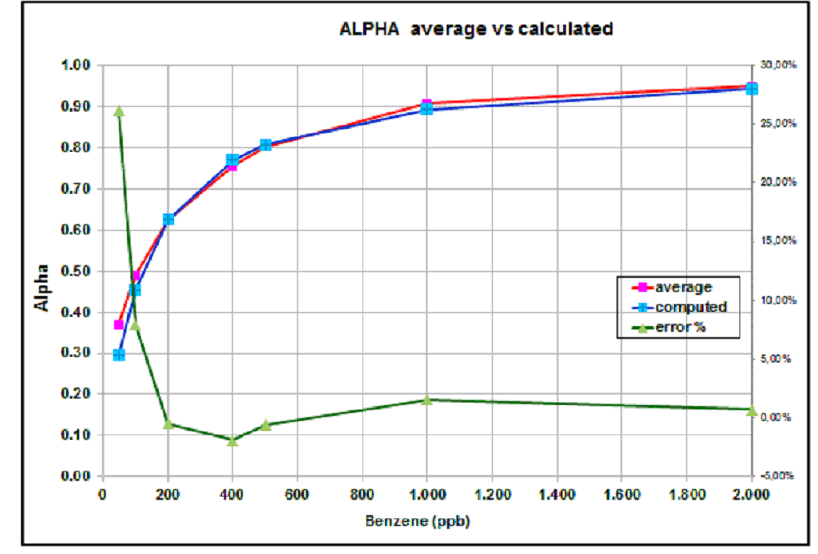
Figure 7. Average, measured α function and relative error percentage.